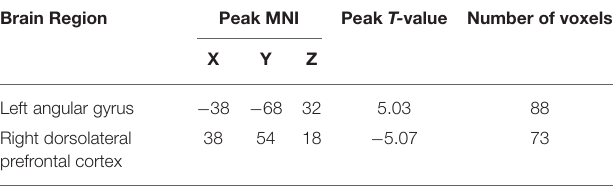
Peak MNI coordinates for brain regions with significantly altered right amygdala rsFC in adolescents with NeuP compared to healthy controls, significant at